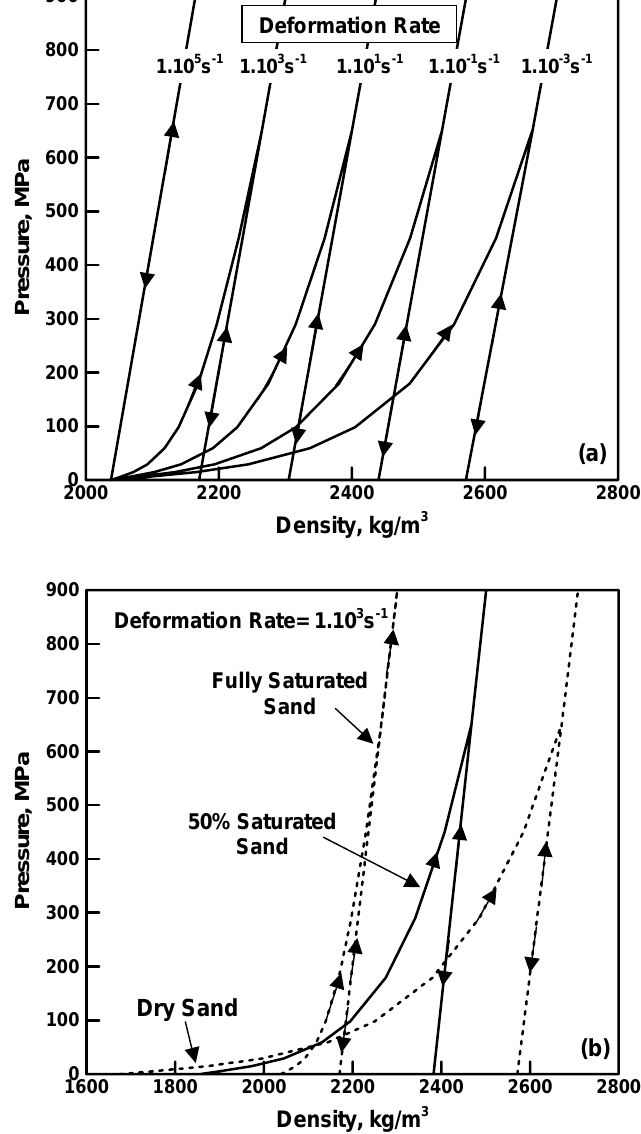
Fig. 4. Pressure vs. density relation for: (a) fully saturated sand with a porosity level of 38% at various deformation rates and (b) for sand at different degrees of saturation and a deformation rate of 1.10 3 s − 1 . (a) The type of sand appears to have a relatively small effect on the impulse transfer. This conclusion was partly based on the results displayed on Fig. 5. and partly on the conclusions made in Ref.